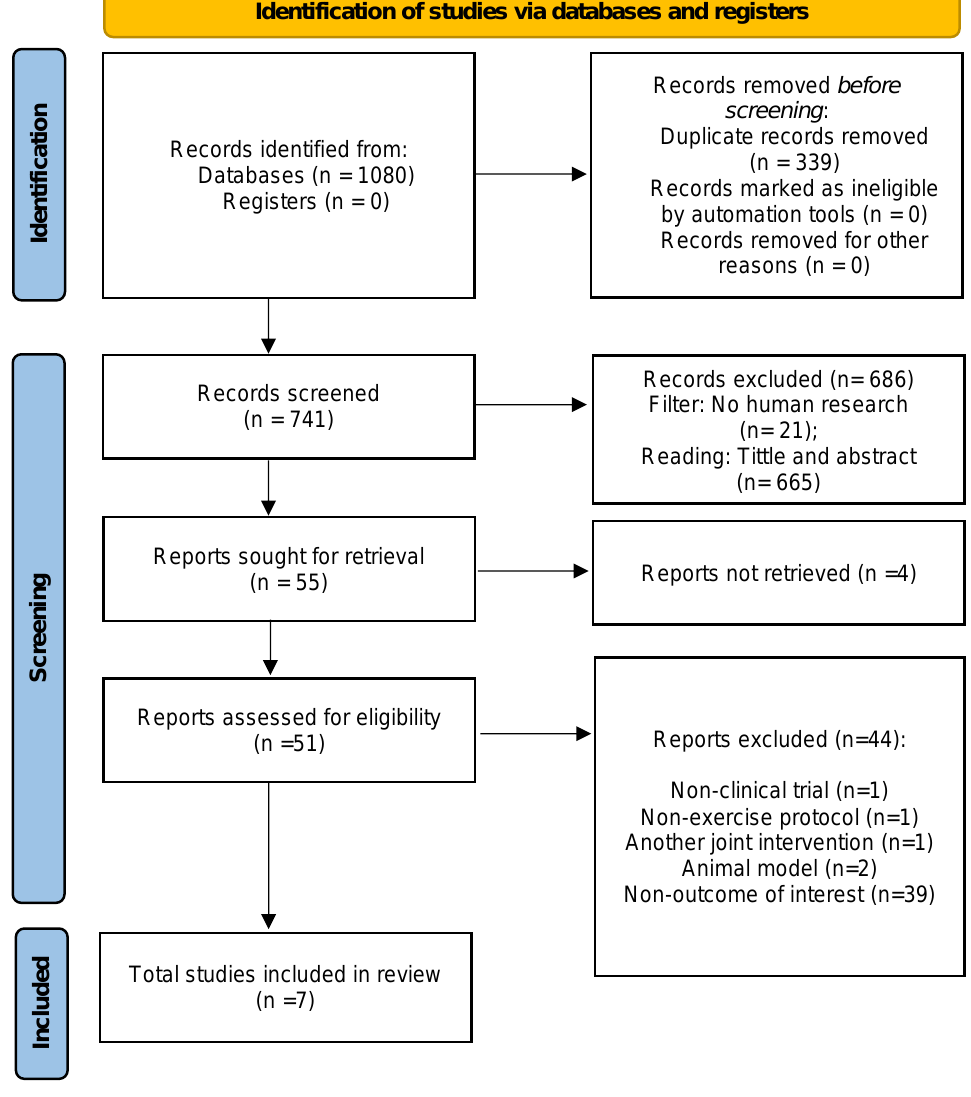
Figure 1. PRISMA 2020 flow